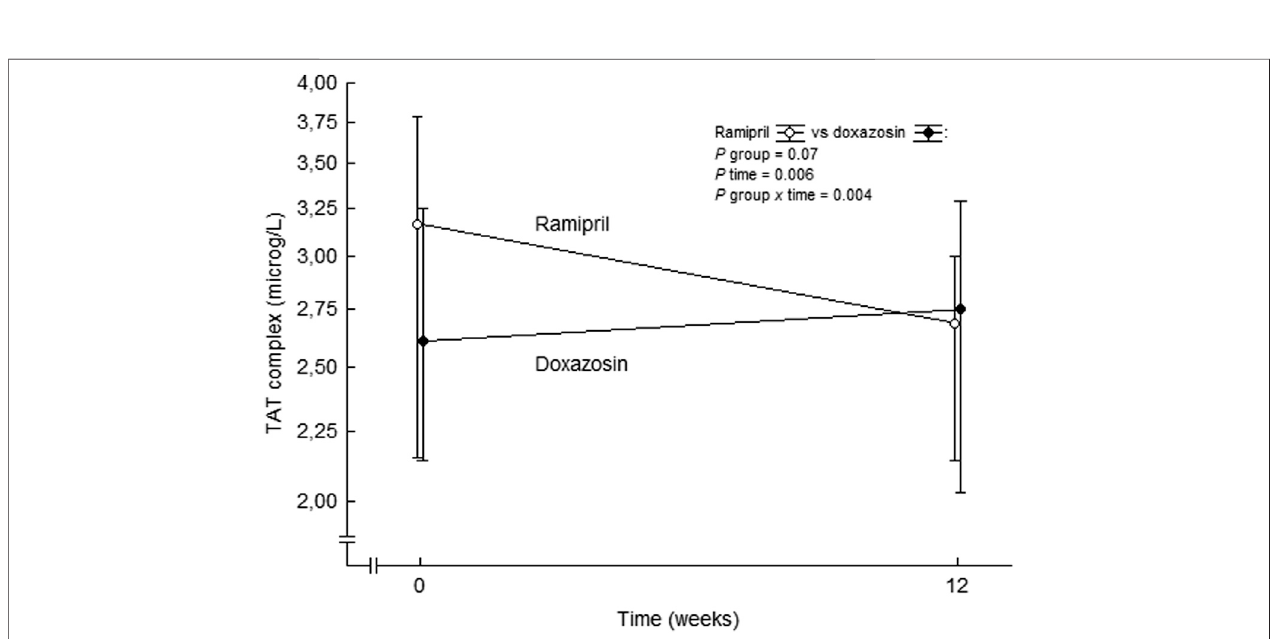
FIGURE6| TATcomplexlevelsatbaselineandafter3 monthsofdouble-blindtreatmentwithramiprilordoxazosininpatientswithessentialhypertension.Dataare presented as mean values ± SD, n (cid:1) 28 for the ramipril group and n (cid:1) 22 for the doxazosin group. Statistical evaluation was made by multivariate analysis of variance. TAT, thrombin-antithrombin. From (Ekholm et al., 2018).